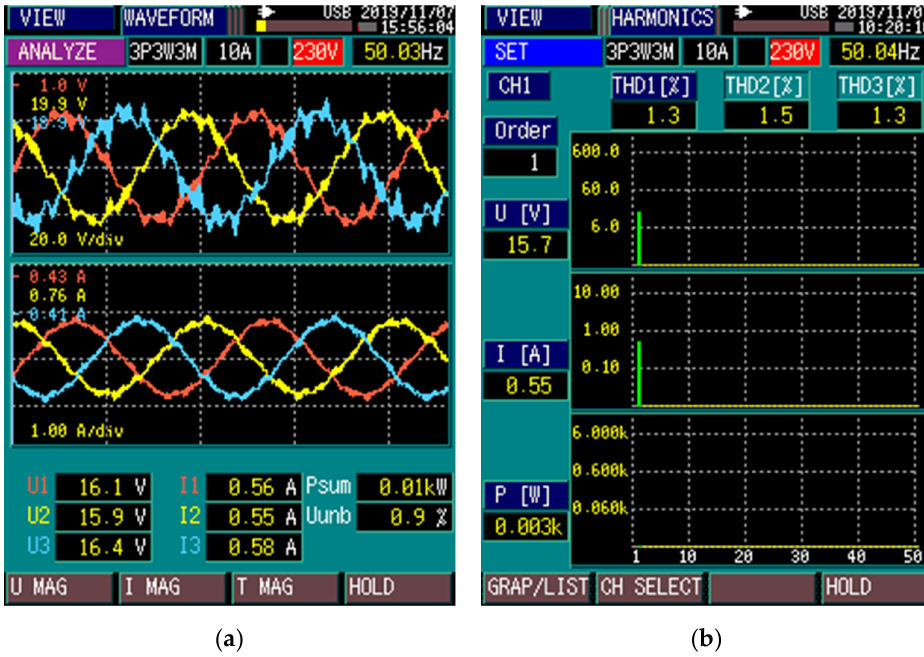
Figure 28. The HIOKI Power Quality Analyzer output of the FS-PDCC based two-level three-phase VSI: ( a ) waveform mode showing output voltage and current, ( b ) Harmonics mode.